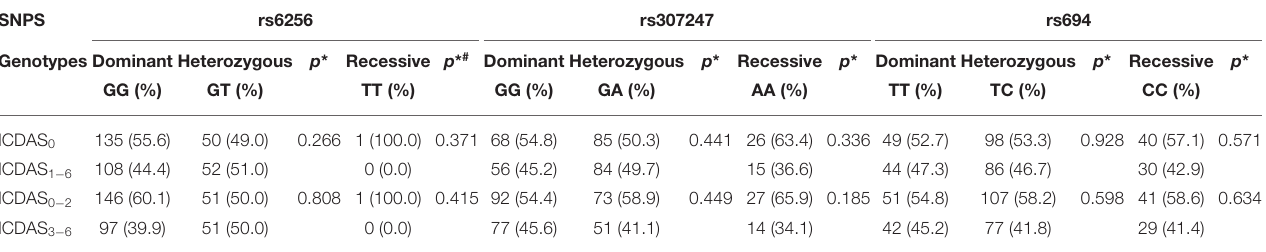
TABLE 4 | Genotype distribution between Healthy vs. Dental caries (ICDAS 0 vs. ICDAS 1 − 6 ) and Healthy and non-cavitated caries lesion vs. Cavitated caries lesion (ICDAS 0 − 2 vs. ICDAS 3 − 6 ).